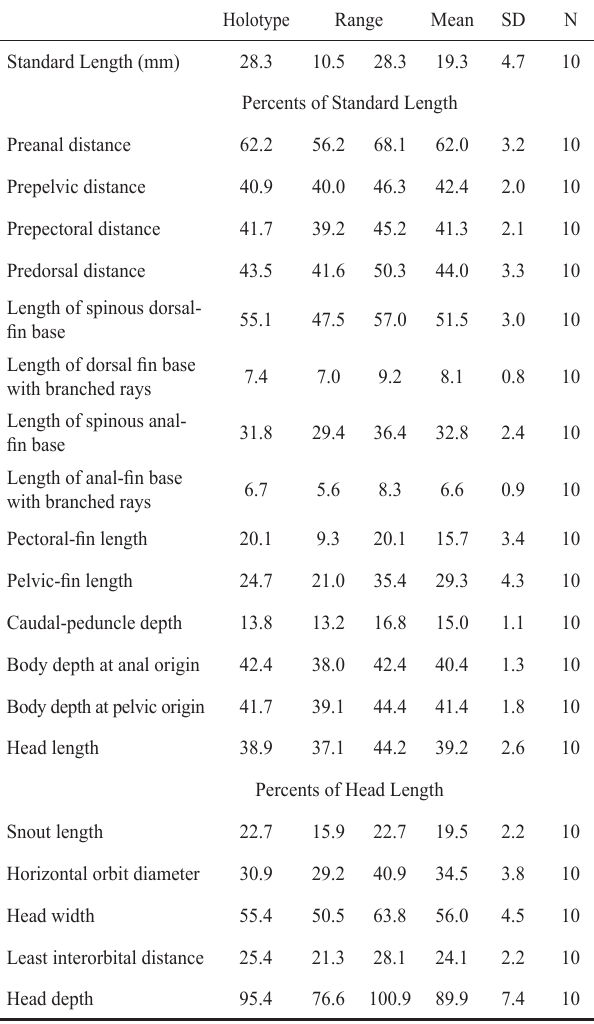
Table 1 . Morphometric data of Polycentrus jundia . SD